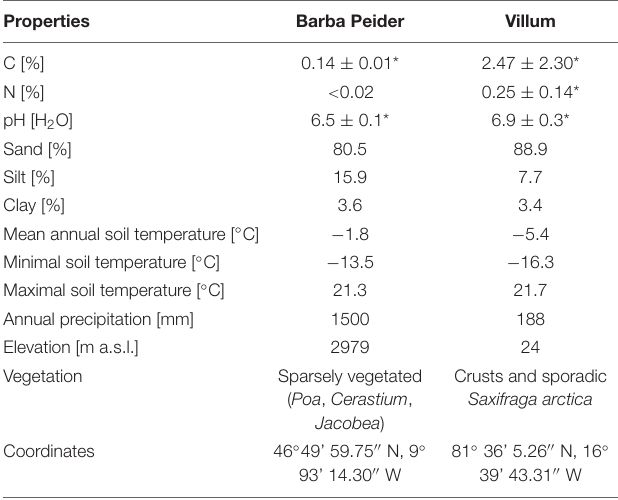
TABLE 1 | Physico-chemical and site characteristics of soils used in the microcosm